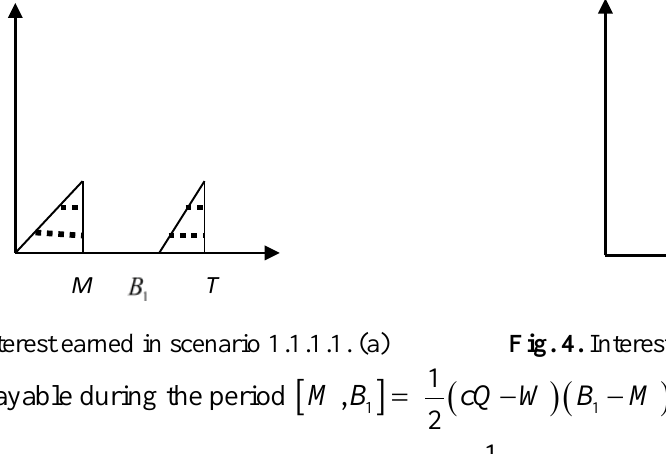
Fig. 3. Interest earned in scenario 1.1.1.1. (a) Fig. 4. Interest payable in scenario 1.1.1.1.